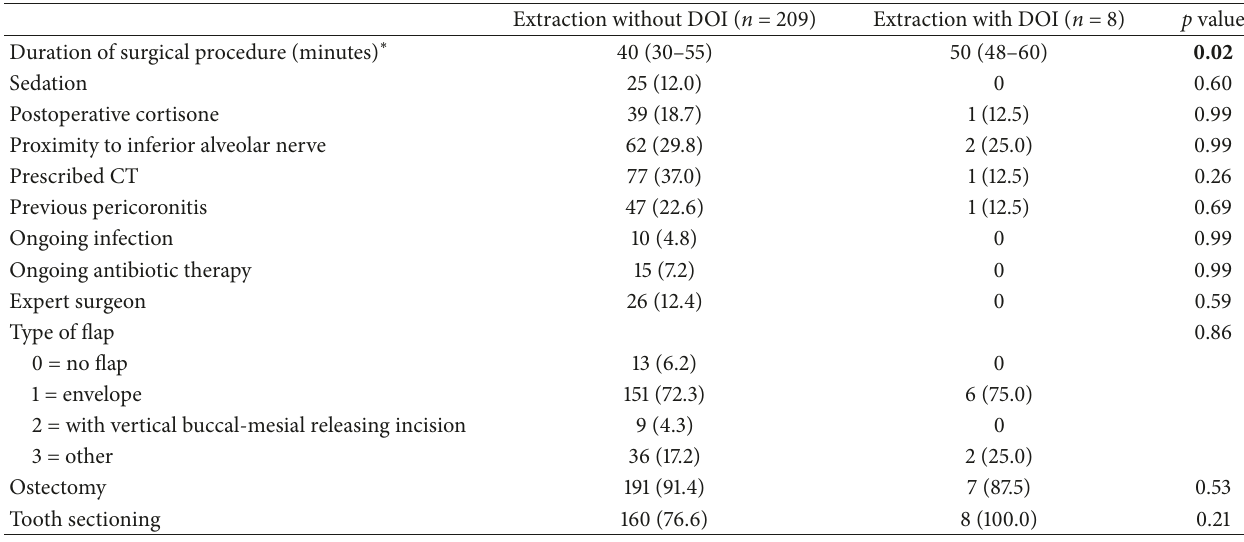
Table 2: Variables recorded at the time of surgery (𝑇 0 ) .